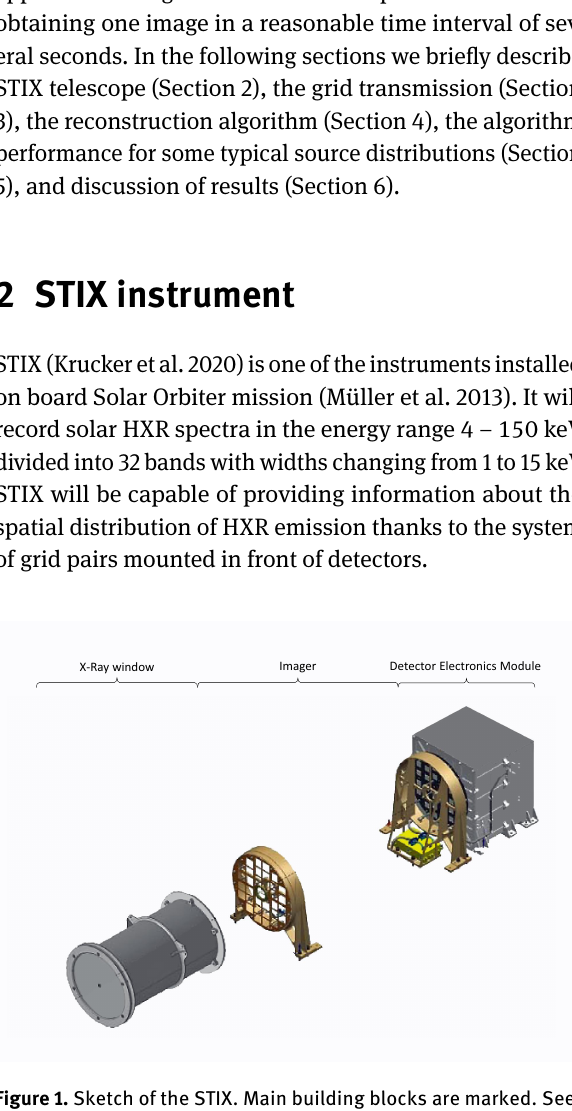
Figure 1. Sketch of the STIX. Main building blocks are marked. See text for further details.